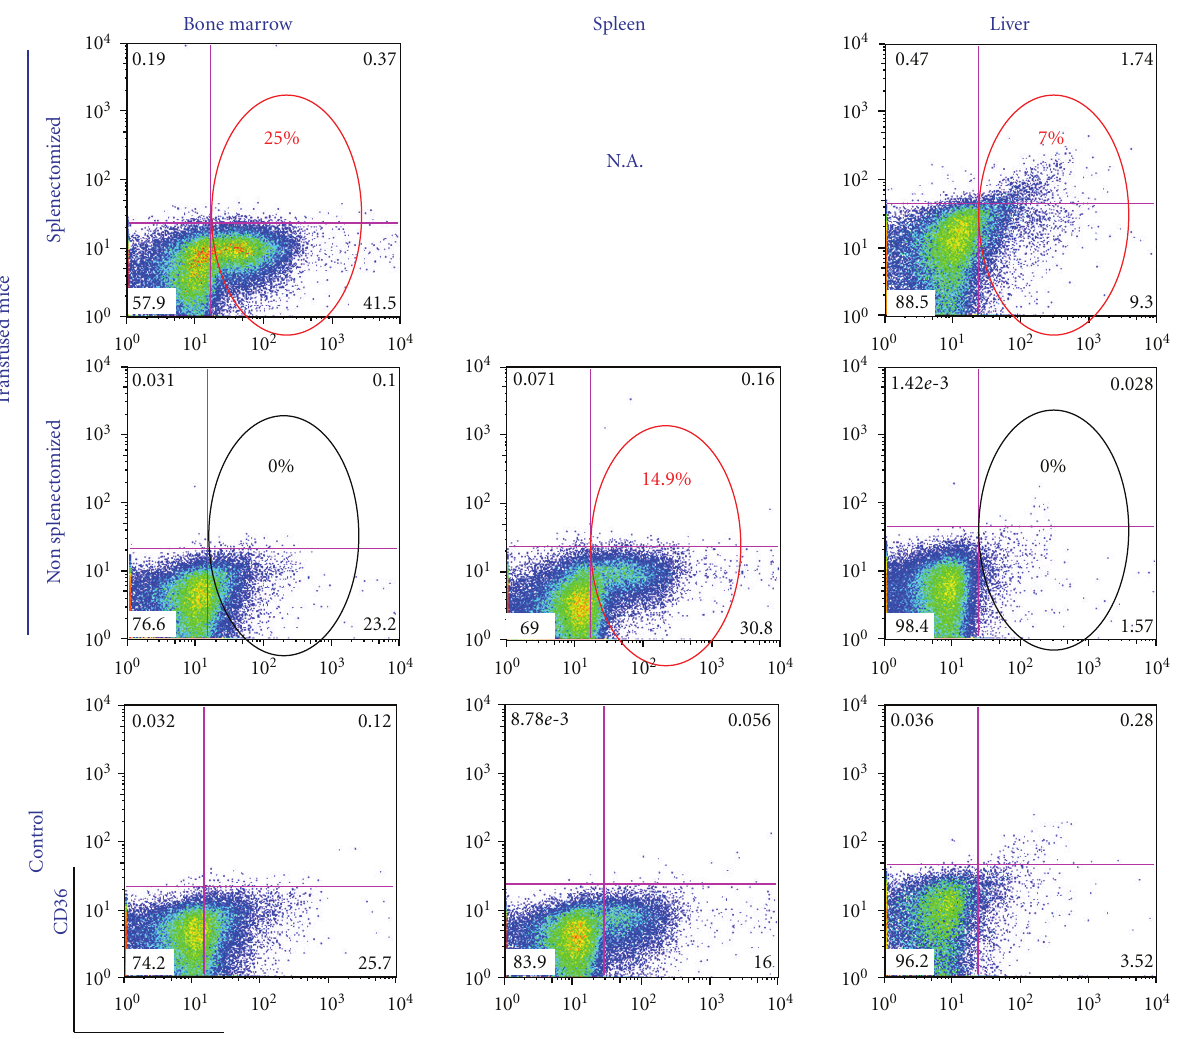
Figure 7: By flow cytometry of human CD36/CD235a expression, human CD235a pos cells were detectable in marrow and liver of splenectomized mice 4 days after transfusion. Flow cytometry analysis of bone marrow (left panels), spleen (middle panels) and liver (right panels) from splenectomized (top panels), non splenectomized (middle panels), and nontransfused controls (bottom panels) of representative mice are shown. The small numbers indicate the frequency of the cells detected within the respective quadrant. Values within circles correspond to the percentage of human cells calculated by subtracting the frequency detected in the negative controls in the corresponding bottom panels. The red circles indicate the frequency of human cells. Of note, the majority of the human CD235a positive cells were negative for CD36, an indication that the human EBs had matured in vivo . Similar results were obtained by analyzing the cells for eGFP expression. Data are representative of those obtained with 3 mice per experimental